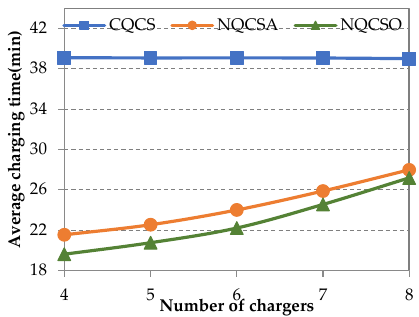
Figure 9. Average charging time of charged EVs during the simulation period in different charging situations.